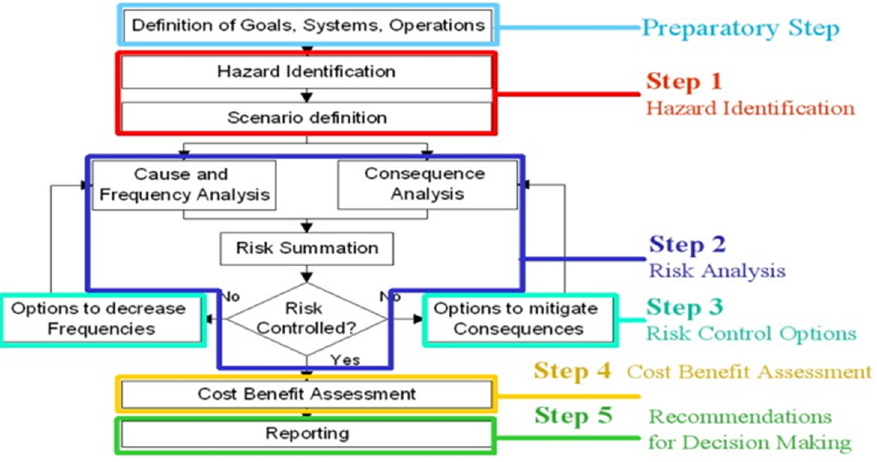
Figure 2. The Formal Safety Assessment (FSA) procedures.